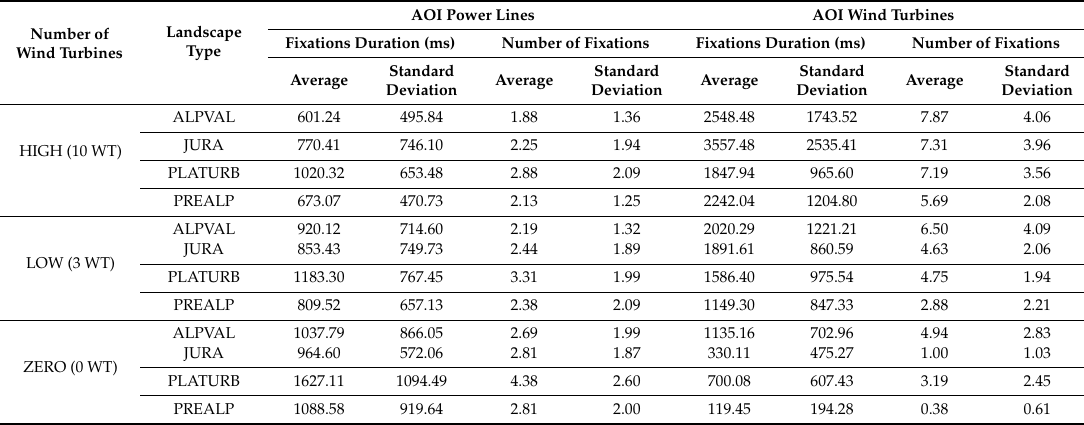
Table A1. Weighted fixation durations and number of fixations in the areas of interest (AOI) of power lines and wind turbines in the 12 scenarios with di ff erent numbers of wind turbines (WT) in four di ff erent landscape